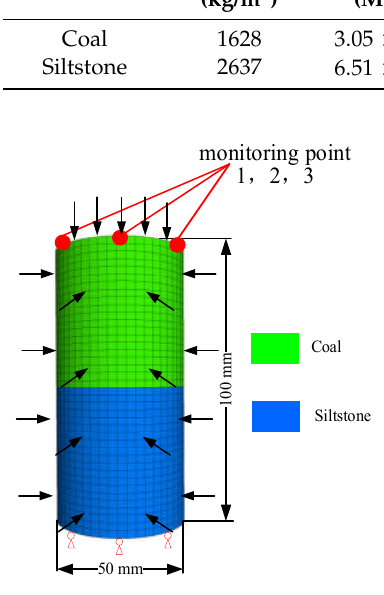
Figure 5. Numerical calculation